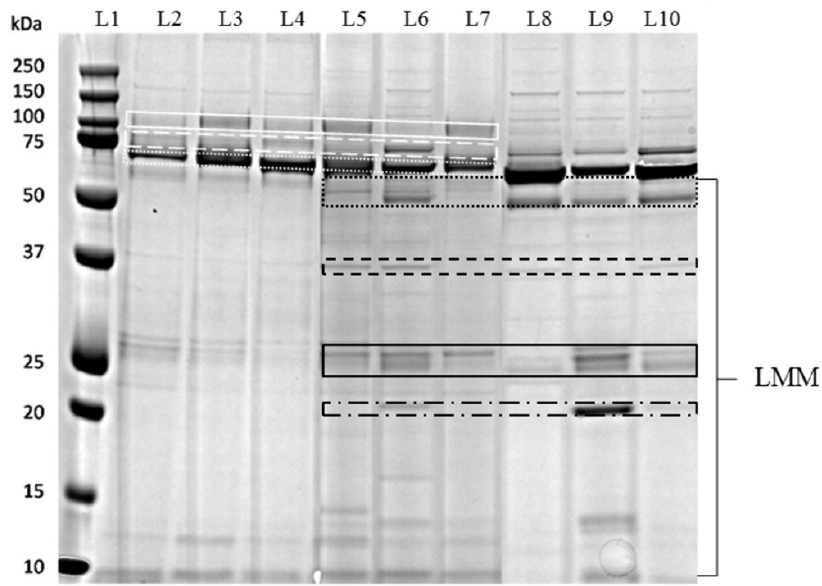
Figure 1. Representative sodium-dodecyl-sulfate-polyacrylamide gel electrophoresis (SDS-PAGE) of cat urine samples: lane 1 (L1), molecular mass marker; lanes 2–4 (L2–L4), urine samples from healthy cats; lanes 5–7 (L5–L7), urine samples from FeMV cats; lanes 8–10 (L8–L10), urine samples from CKD cats. White continuous line indicates uromodulin (100-92 kDa); white dashed line indicates transferrin (76 kDa); white dotted line indicates cauxin and albumin (67-62 kDa); black dotted and black continuous lines indicate immunoglobulin heavy (54 kDa) and light (26 kDa) chains, respectively; black dashed line indicates haptoglobin (36 kDa); black dotted and dashed line indicates retinol binding protein (20 kDa). LMM, low molecular mass.